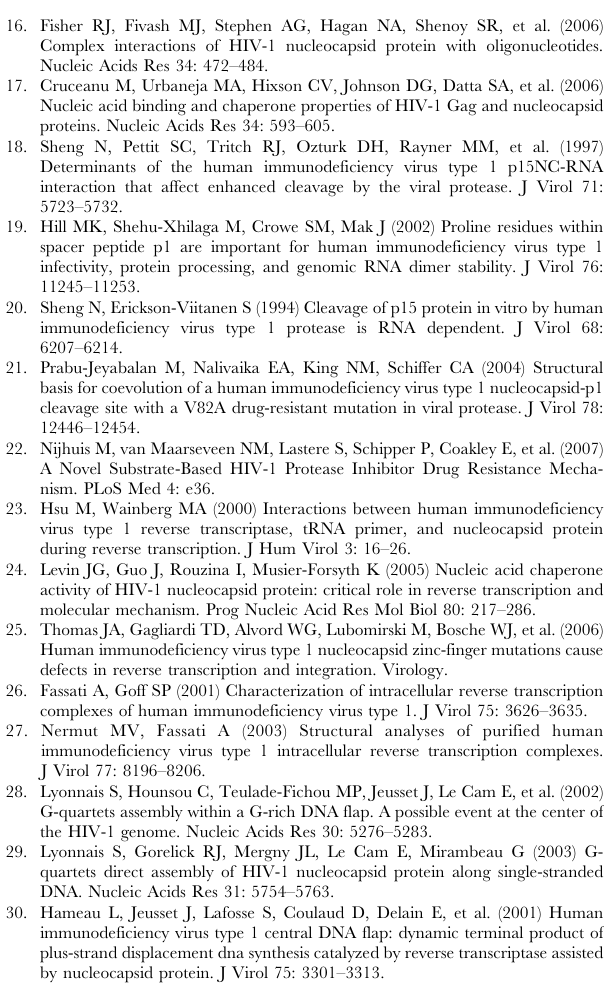
Figure S1 Differences in DNA synthesis depending on the origin of NCp and RT. (A) Comparison of the effects of HIV-1 NCp7, NCp9 and NCp12-53 vs. Mo-MuLV NCp10 (3 m M) on DNA synthesis catalysed by HIV-1 RT (50 nM) and analysed after 10 and 40 min. incubation. Samples were micro-sedimented before electrophoresis to evaluate the level of DNA aggregation. (B) TEM of DNA synthesis after 40 min. of incubation with HIV-1 RT and NCp9. (C) Comparison of DNA synthesis by HIV-1 RT (200 nM) and Mo-MuLV RT (200 U) after 20 and 60 min. in the